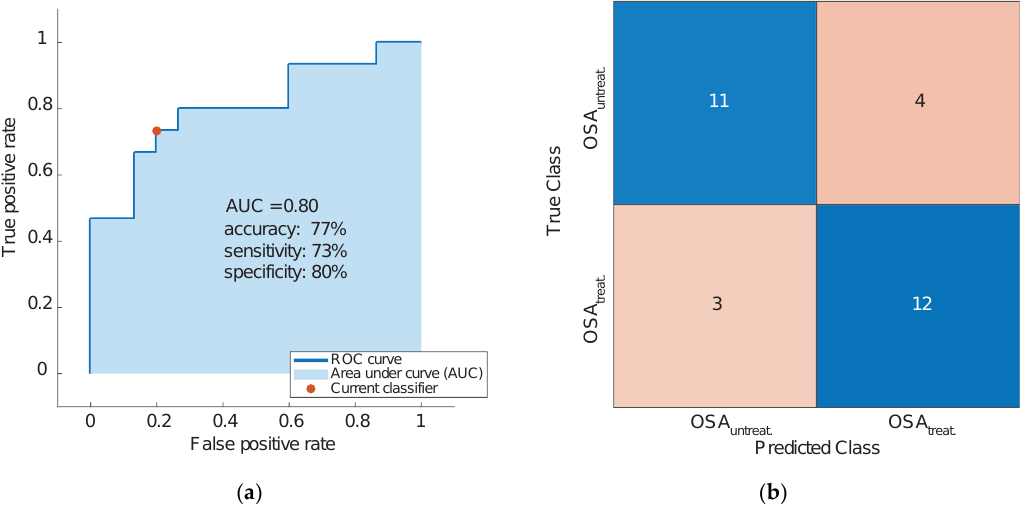
accuracy of 64%, sensitivity of 75% and specificity of 53% (Figure S3). Reducing the un- treated OSA group randomly for a balanced group size to build the prediction model re- sulted in an AUC of 0.80 and strongly improved accuracy (77%) and specificity (80%), but at the slight expense of sensitivity (73%) (Figure 3).